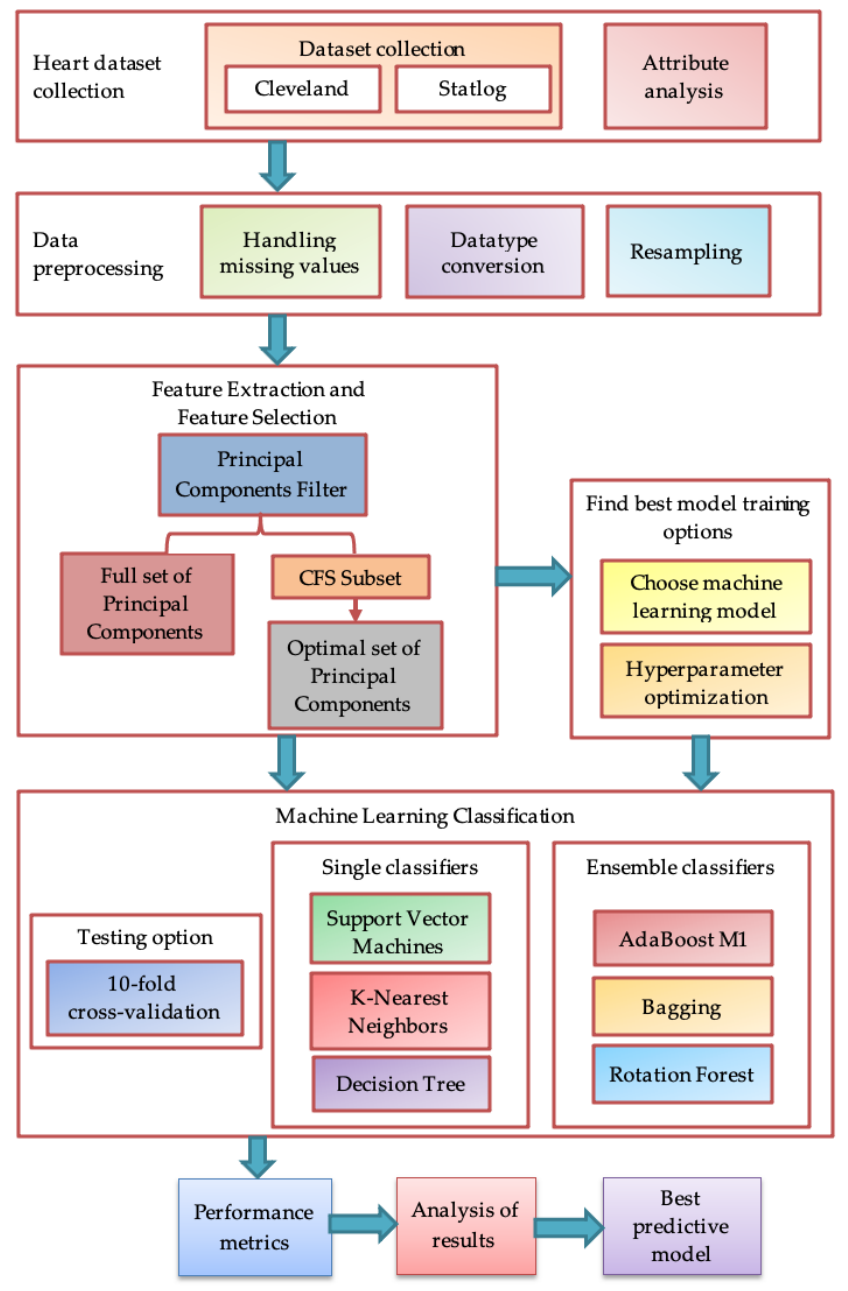
Figure 3. Block diagram of the proposed methodology.